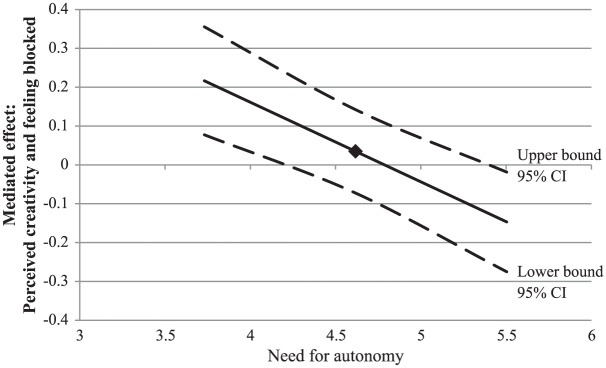
Study 1: A plot of the conditional indirect effect of input novelty
on feeling blocked through perceived creativity, conditioned on the
moderator (need for autonomy), with 95% confidence bands.Note. The square indicates the mean level of the
need strength. CI = confidence interval.